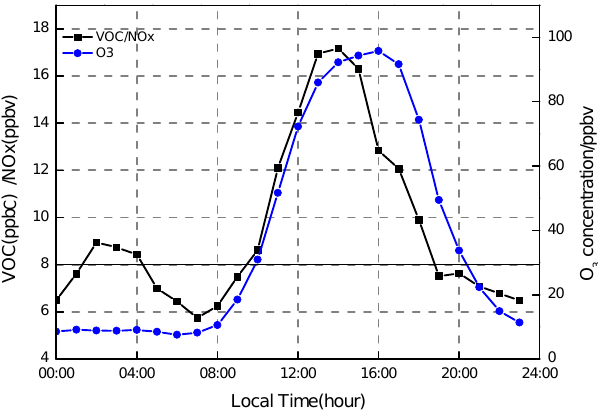
Figure 8. The seasonal frequency distribution of hourly ozone con- centrations from summer 2011 to spring 2012 at GPACS plotted by bar.